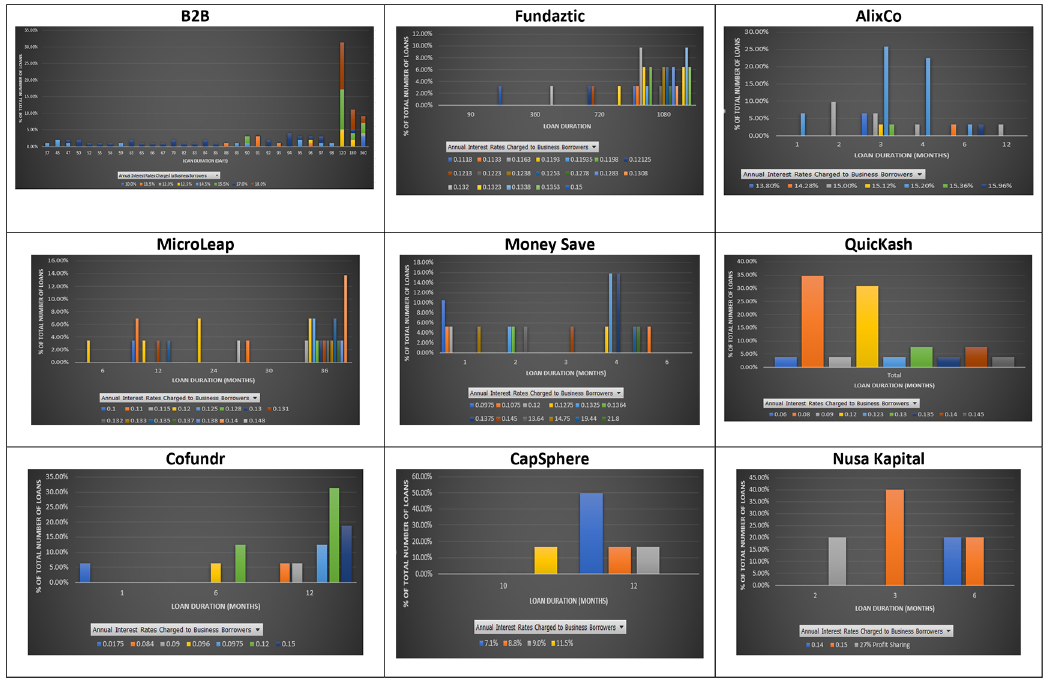
Figure 3. Interest rates and loan durations at nine P2P lending